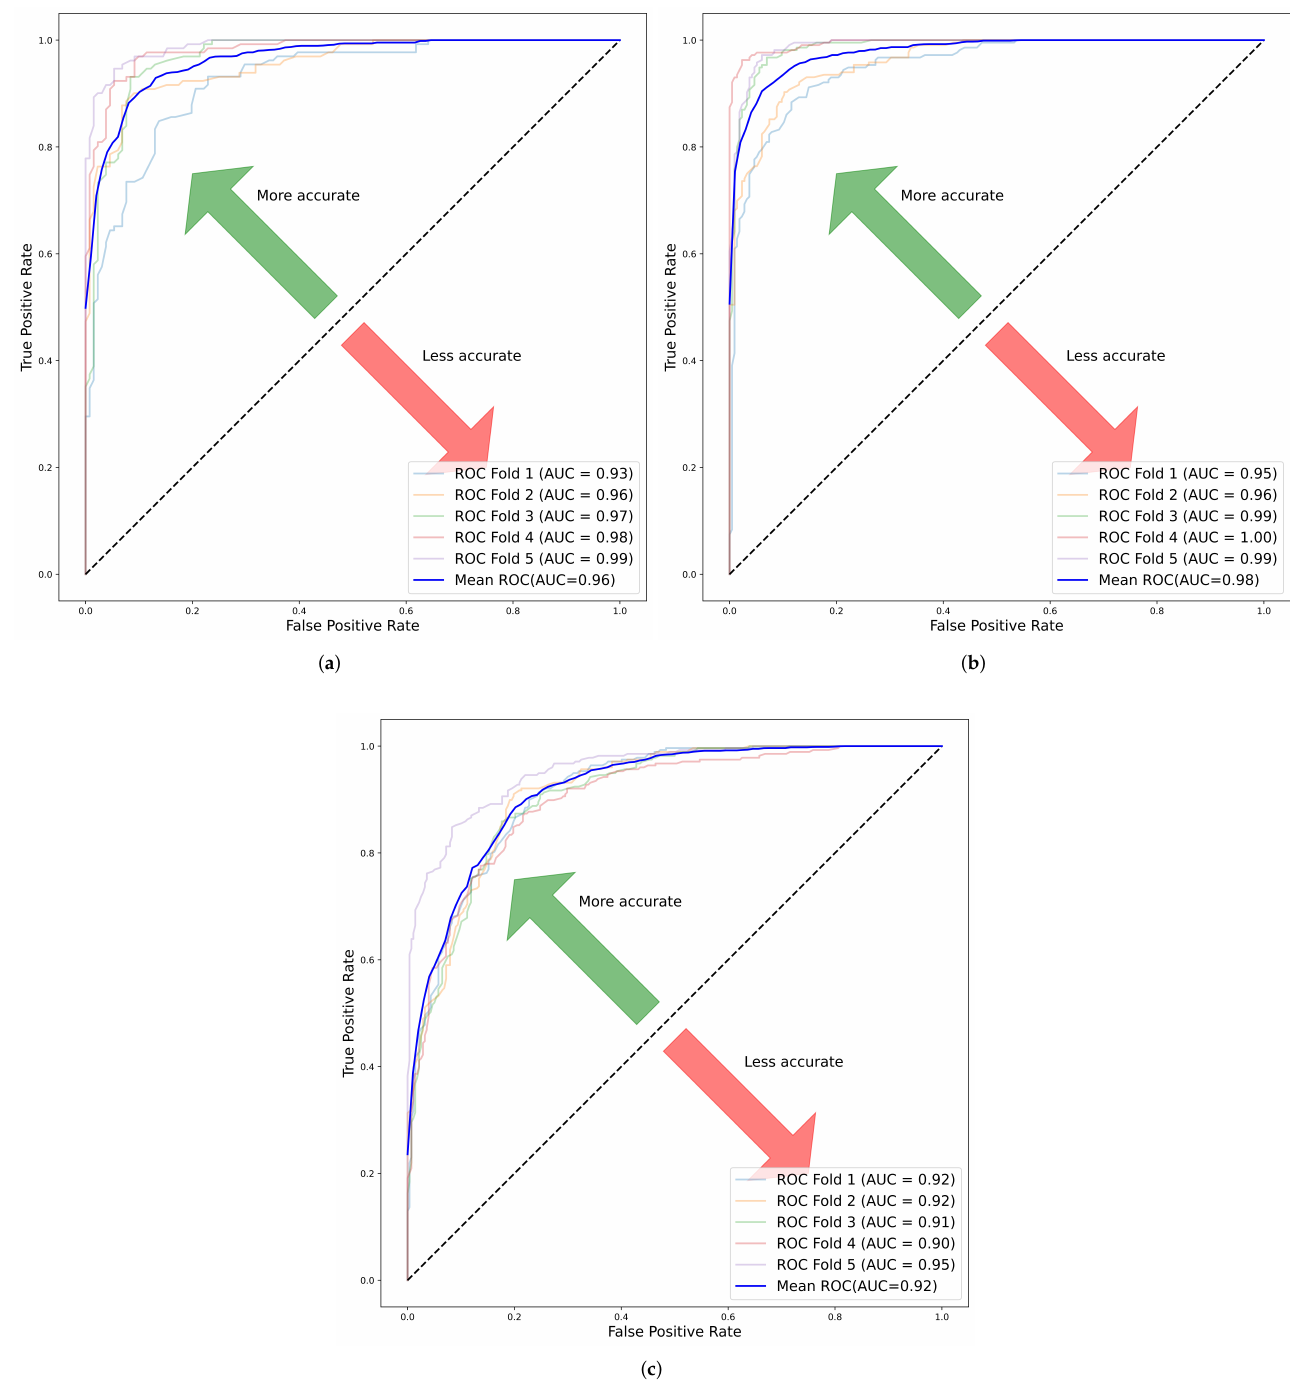
Figure A2. ( a ) ROC RF All Tumor Slices Filtered Cohort 1. ( b ) ROC RF All Tumor Slices Filtered Cohort 2. ( c ) ROC RF All Tumor Slices Filtered Combined